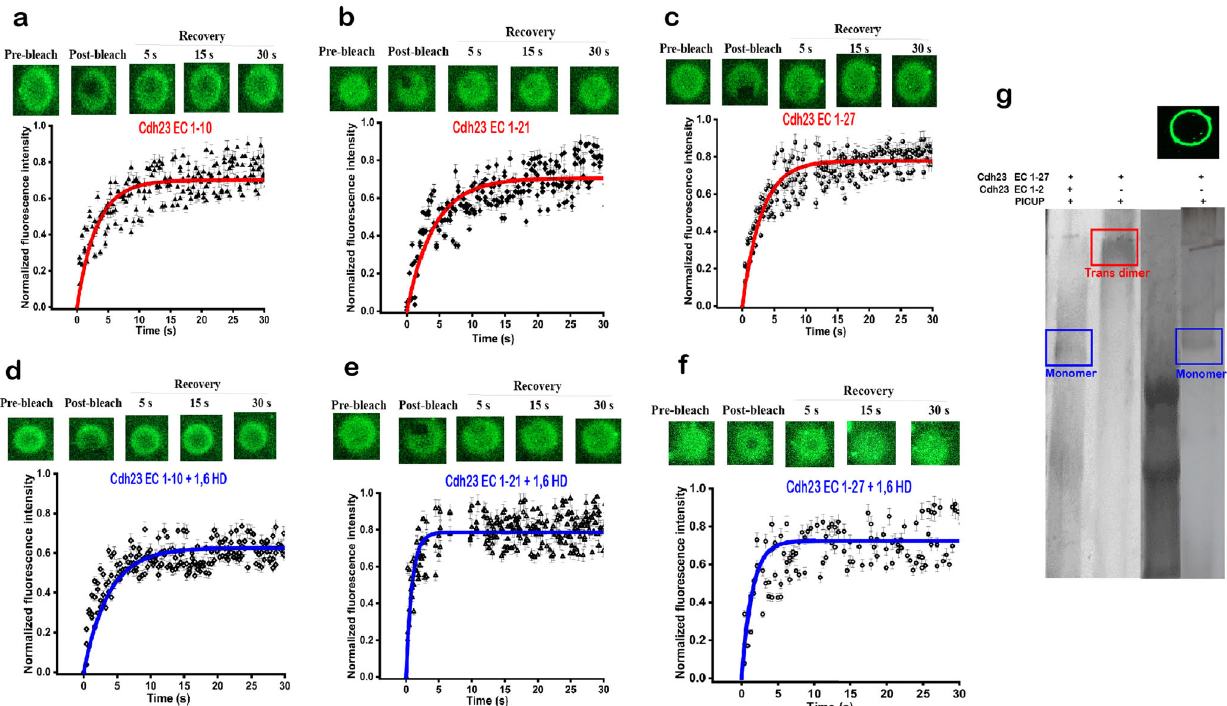
Fig. 2 Cdh23 forms lateral clusters on GUV membranes. a – f The fl uorescence images of GUVs marking the pre-bleach, bleach, and post-bleach recovery regions at selected time points (upper panel), and the corresponding fl uorescence recovery pro fi le (normalized) (lower panel). a – c Are for GUVs anchored with Cdh23 EC1-10, Cdh23 EC 1-21, and Cdh23 EC1-27, respectively. d – f Are for the same GUVs anchored with Cdh23 EC1-10, Cdh23 EC 1-21, and Cdh23 EC1-27, respectively but after 1,6-HD treatment. The solid lines represent the fi tting of the fl uorescence recovery over time to the model (see methods). ( g ) PICUP on the clusters of Cdh23 EC1-27 on GUV membranes identi fi es only the monomer band in the silver stained SDS-PAGE. Middle panel is the repeat of Fig. 1b, indicating the relative position of the dimer band in red box. The upper inset shows the eGFP- fl uorescent image of the representative GUVs used for